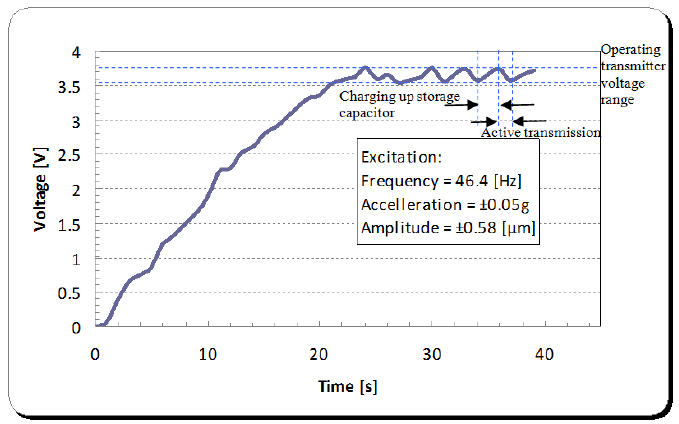
Figure 27. Voltage built up in the storage capacitor of the energy harvester and read-out circuitry assembly.